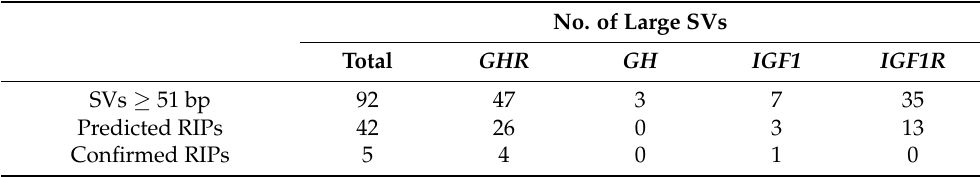
Table 1. Large structural variations (SVs) predicted by alignment in GH , GHR , IGF1 , and IGF1R genes and their flanking